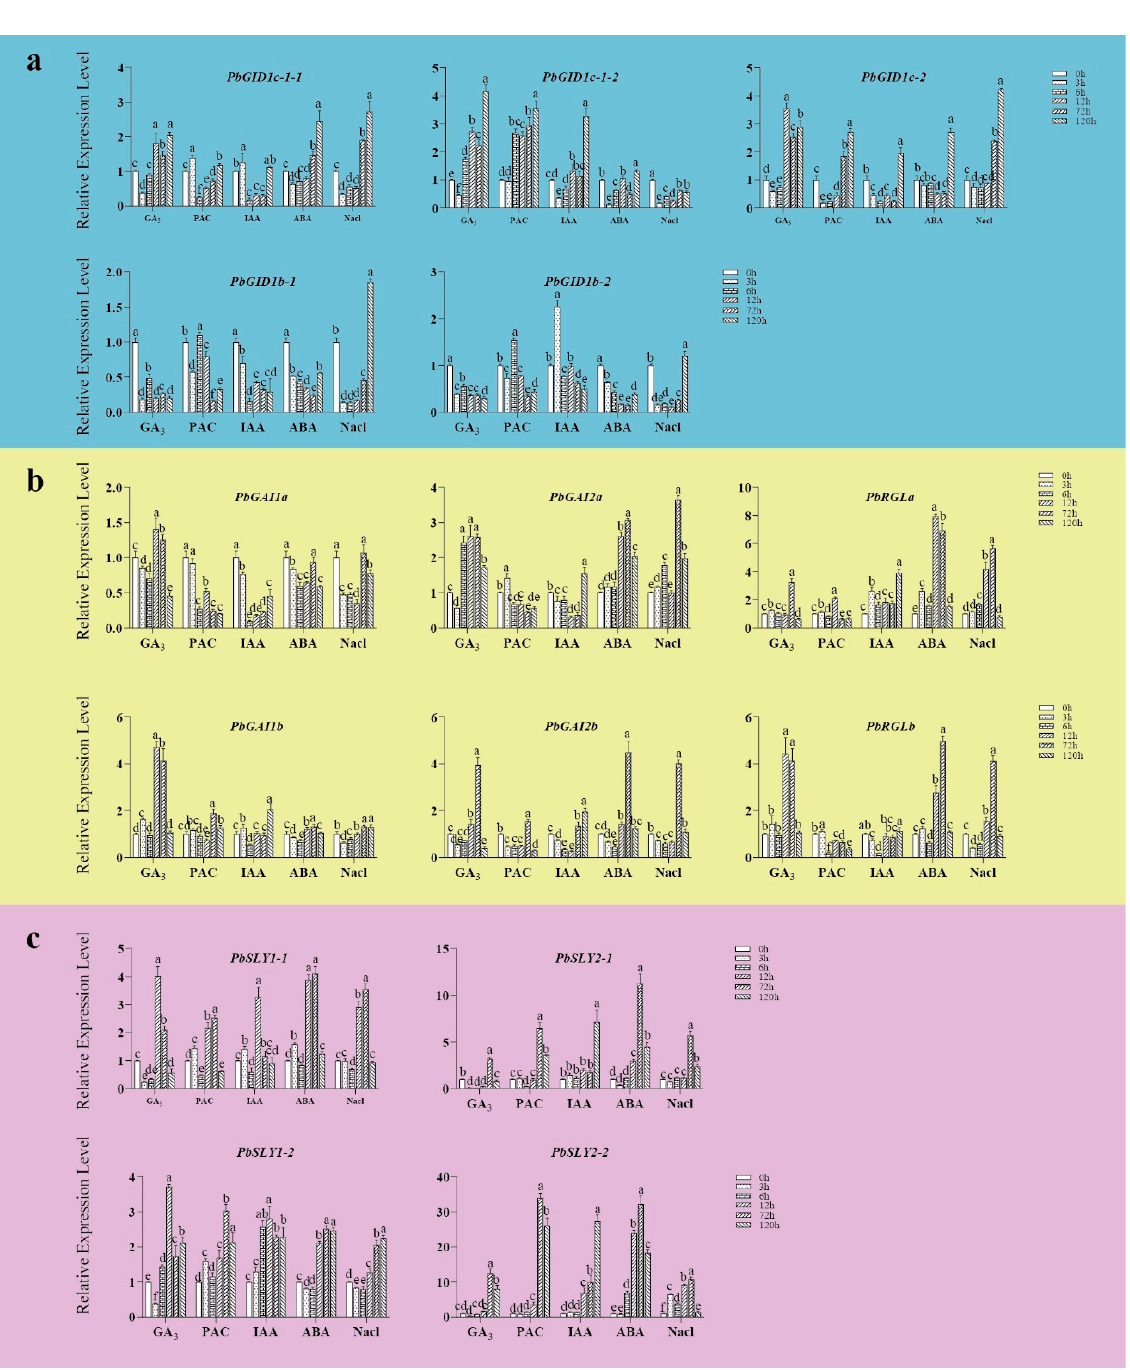
Figure 7. Expression profiles monitored by real-time RT-PCR of PbGID1s , PbDELLAs , and PbSLYs in ‘ duli ’ tissue-cultured seedlings treated with GA 3 , PAC, IAA, ABA, and NaCl. ( a ) Expression profiles of PbGID1s (shaded blue). ( b ) Expression profiles of PbDELLAs (shaded yellow). ( c ) Expression profiles of PbSLYs (shaded lilac). Quantitative RT-PCR was carried out using total RNA isolated from tissue-cultured ‘ duli ’ seedlings treated with GA 3 (2mg/L), PAC (2 mg/L), IAA (0.2 mg/L), ABA (4 mg/L), and NaCl (0.6%) for 0, 3, 6, 12, 72, and 120 h. PbACTIN was used as the reference gene. The relative expression level of each gene was calculated relative to the transcript level of that gene at 0 h (set as 1). Each bar represents the mean ± SE ( n = 3). Different letters above the bars indicate significant differences at p < 0.05 ( n = 3) analyzed by Duncan’s multiple range test.